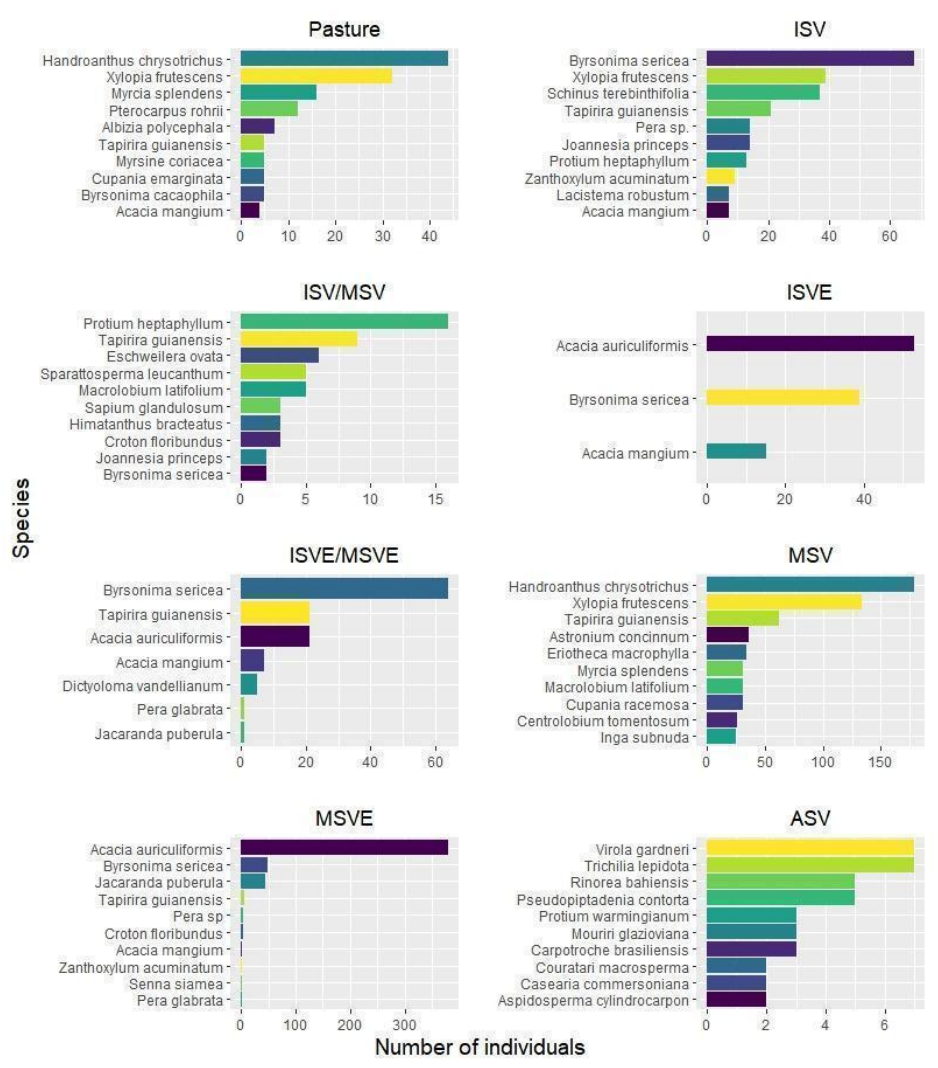
Figure 5. Frequency of species by succession stage, according to the stages defined in Table 1.